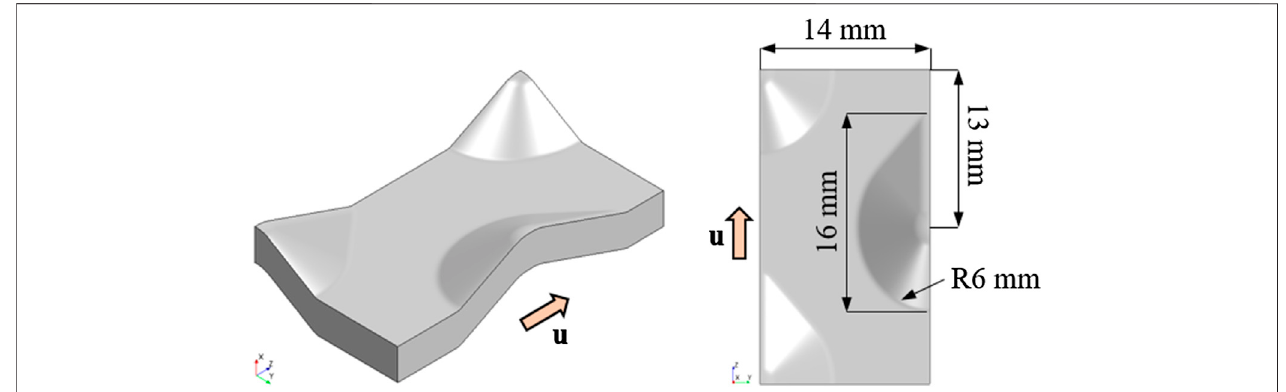
FIGURE 12 | The optimized surface element based on the shape of a droplet.